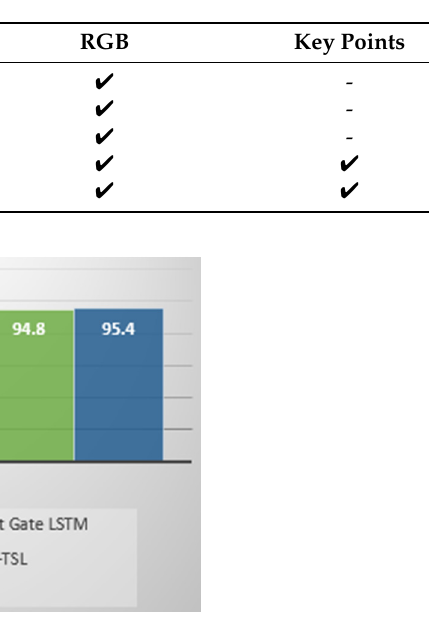
Figure 8. Accuracy comparison with other methods using the Kinetics-Motion dataset.